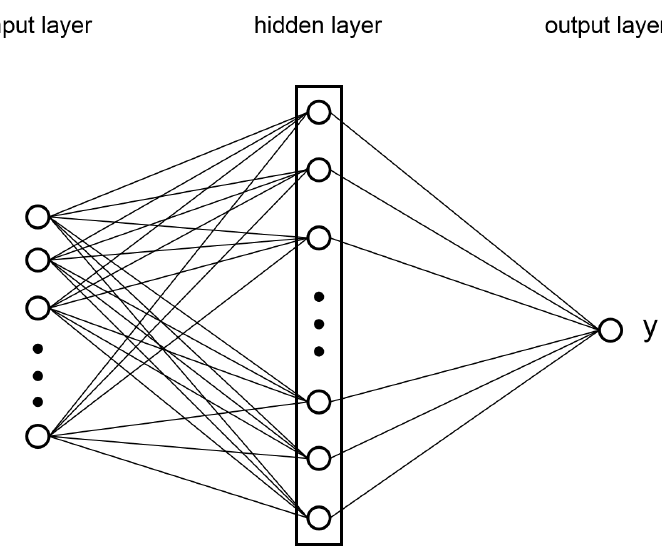
Figure 4. Topological Structure of BP Neural Network.